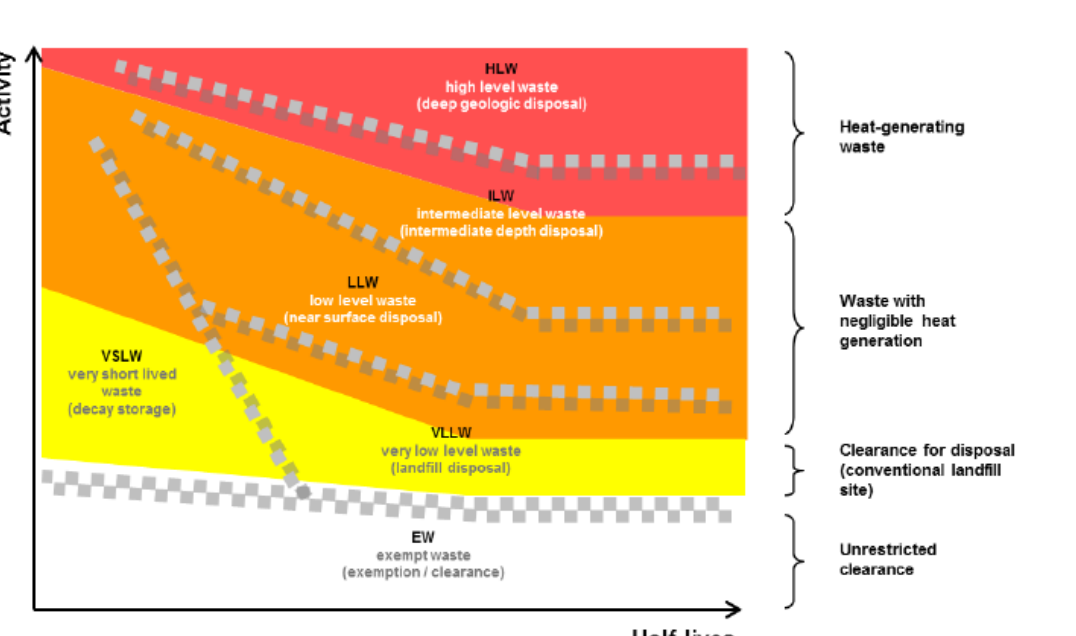
Figure 4. Schematic of nuclear waste classification of